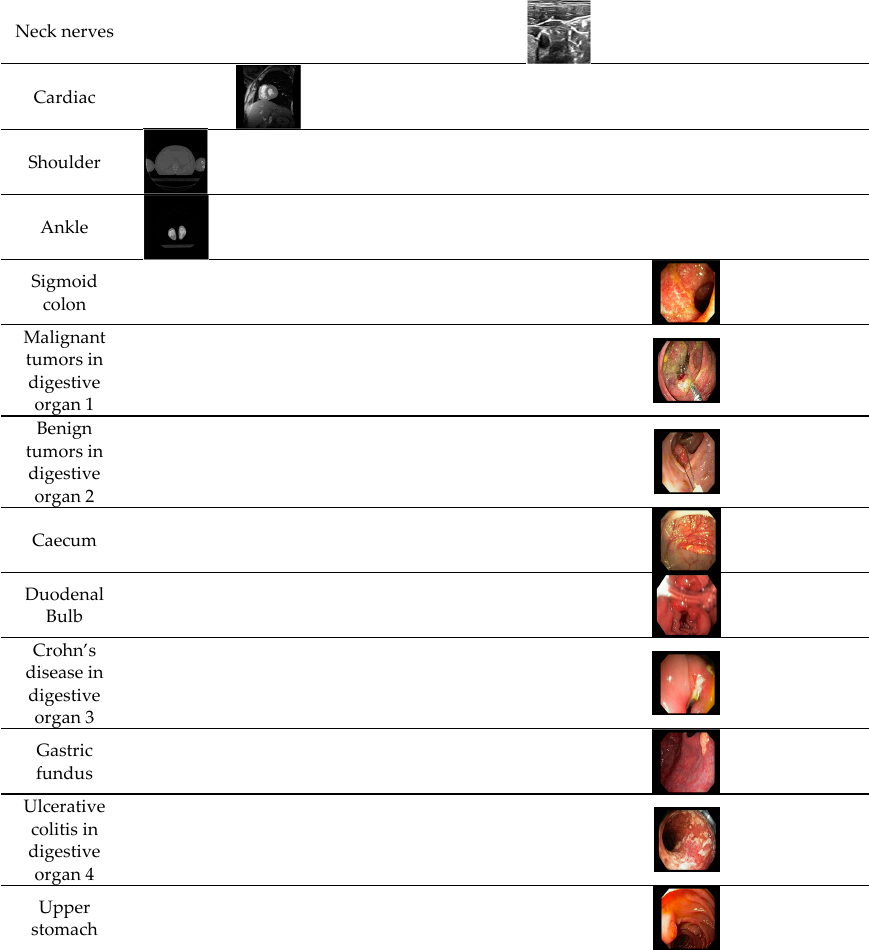
Table 3. Summary of training and testing dataset in two-fold cross-validation (unit: images).